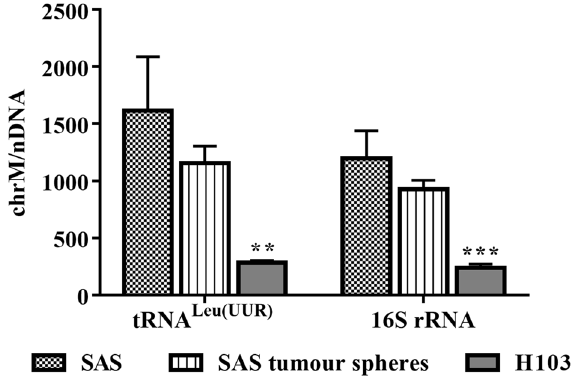
Figure 3. qPCR estimation of mtDNA content. The amplification levels of two mitochondrial genes, tRNA Leu(UUR) and 16S rRNA, were normalised against that of a nuclear gene, β2-microglobulin. Data are presented as mean ± SD. **P < 0.01, ***P < 0.001, n =